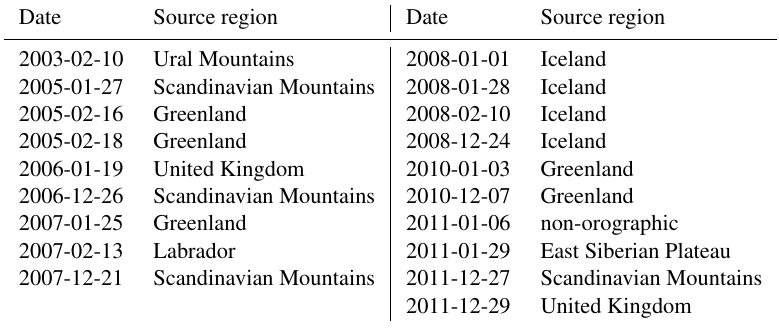
Table 3. Northern Hemisphere gravity-wave-induced PSC formation events.